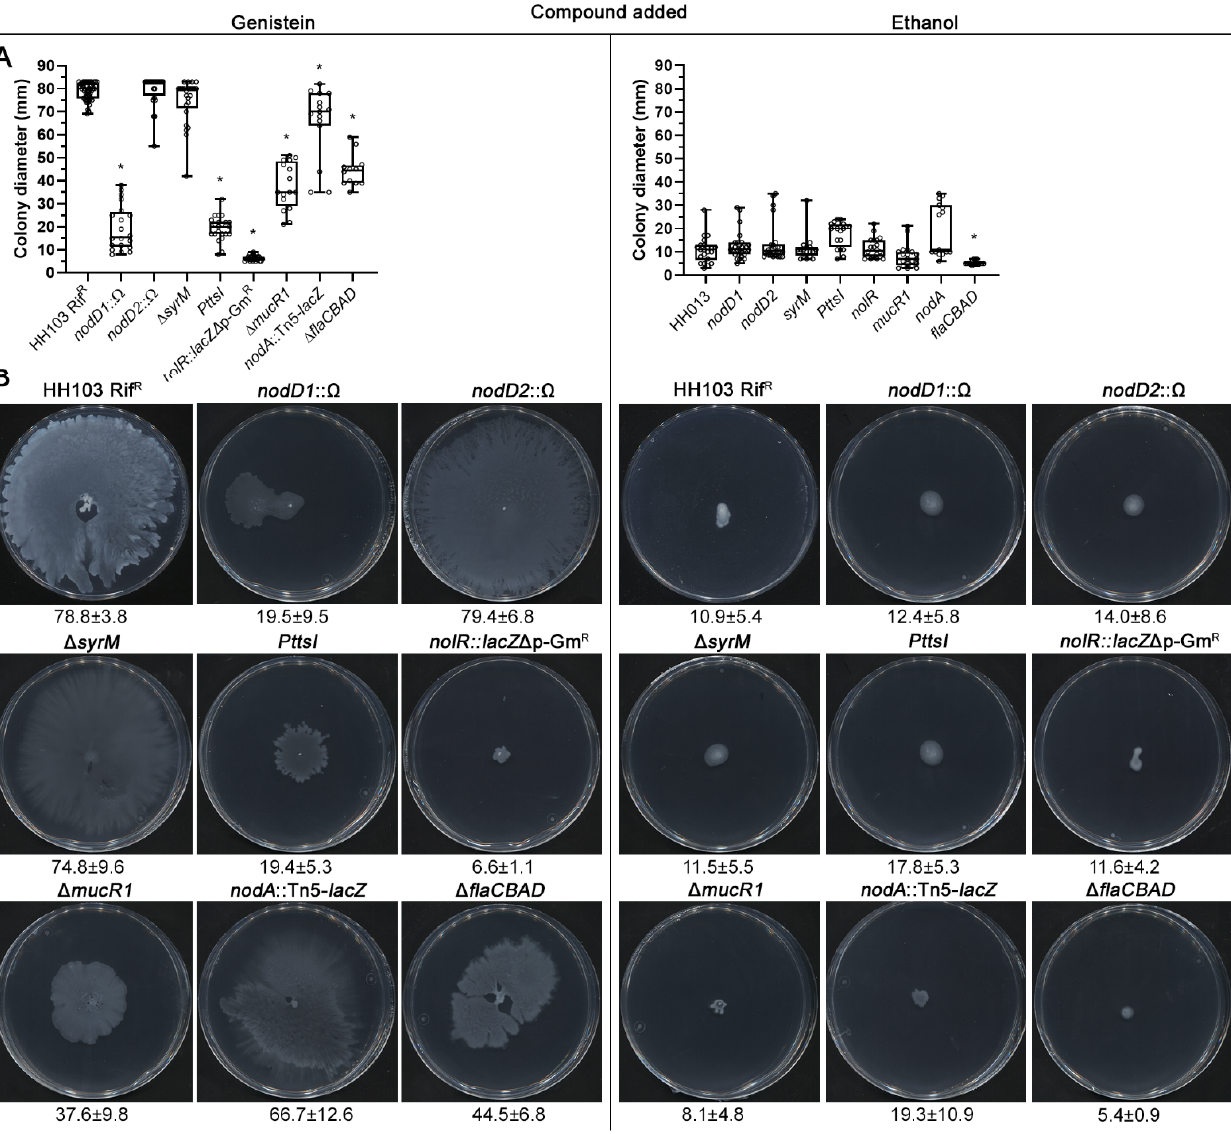
Figure 2. Role of different symbiotic regulators on the S. fredii HH103 surface translocation in the presence of genistein. The non-flagellated ( flaCBAD ) and nodA mutants were also included. Surface motility experiments were performed on minimal medium (MM) using 0.4% agarose as gelling agent and scored at 72 h. ( A ). Box and whisker plots from at least three biological replicates performed with three technical replicates. Asterisks (*) indicate significant differences with the corresponding control sample using the non-parametric test of Mann–Whitney, α = 1%. ( B ). Representative pictures of the motilities exhibited in the presence of genistein by the different S. fredii HH103 mutants analysed. Values under images represent the average and standard deviation of surface migration (given in millimetres and determined as described in the text).